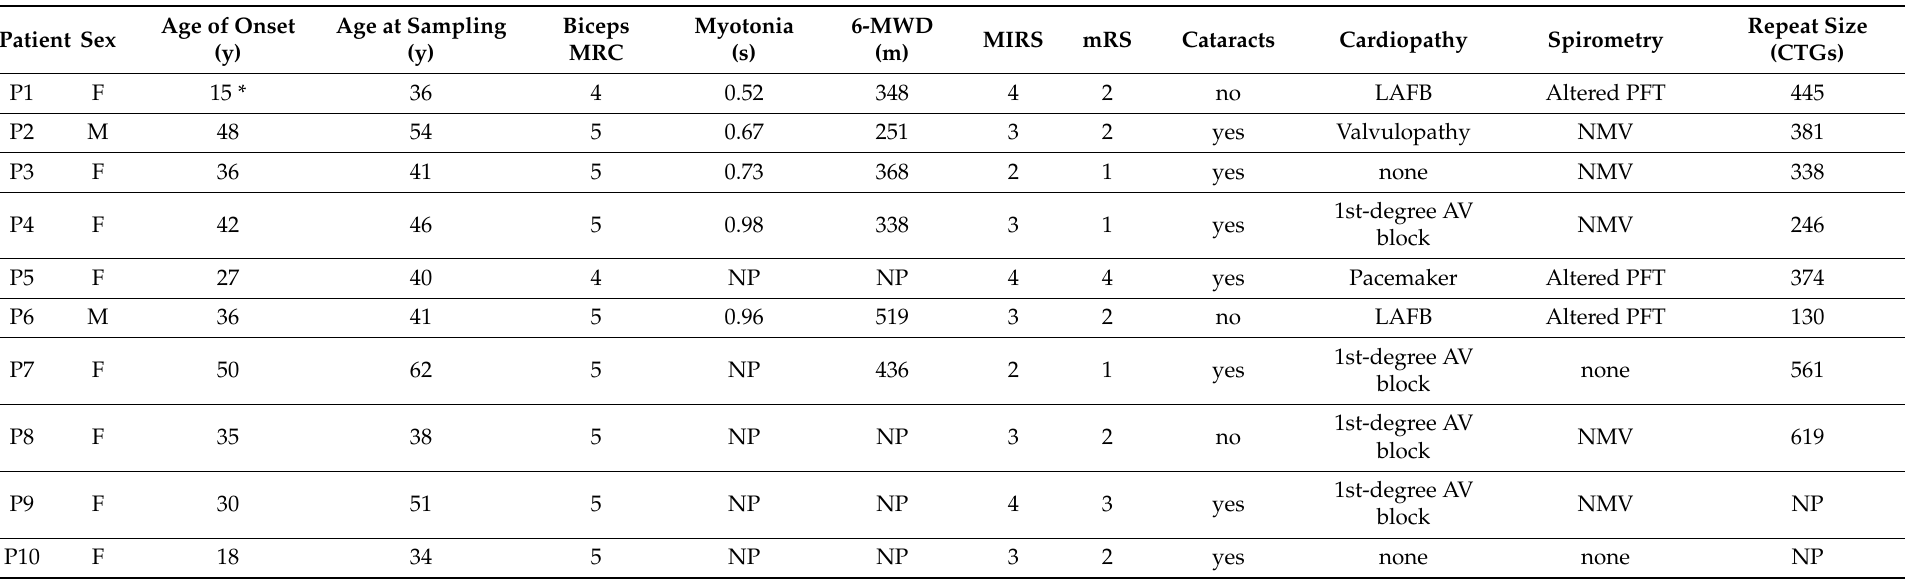
Table 1. Clinical characteristics of Myotonic Dystrophy type 1 (DM1)